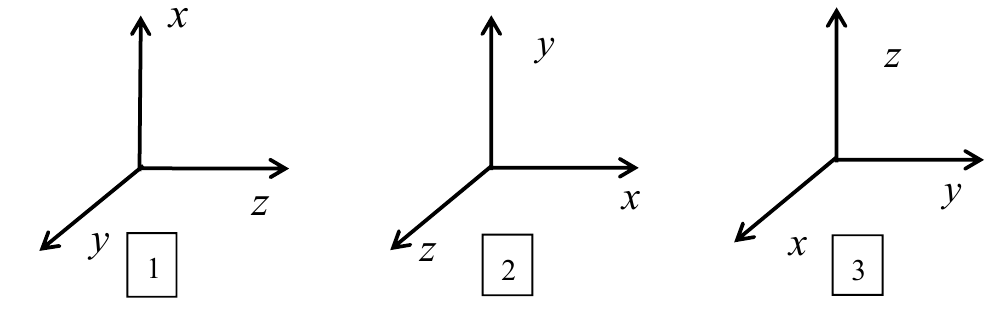
Figure 1. Three-position forward-reverse calibration diagram.